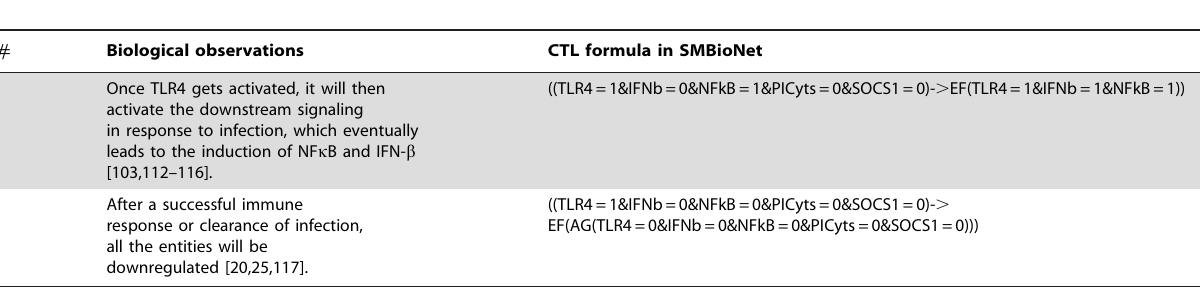
Table 2. Biological observations and concerned references from previous literature which were used to generate the CTL formula as given as input to